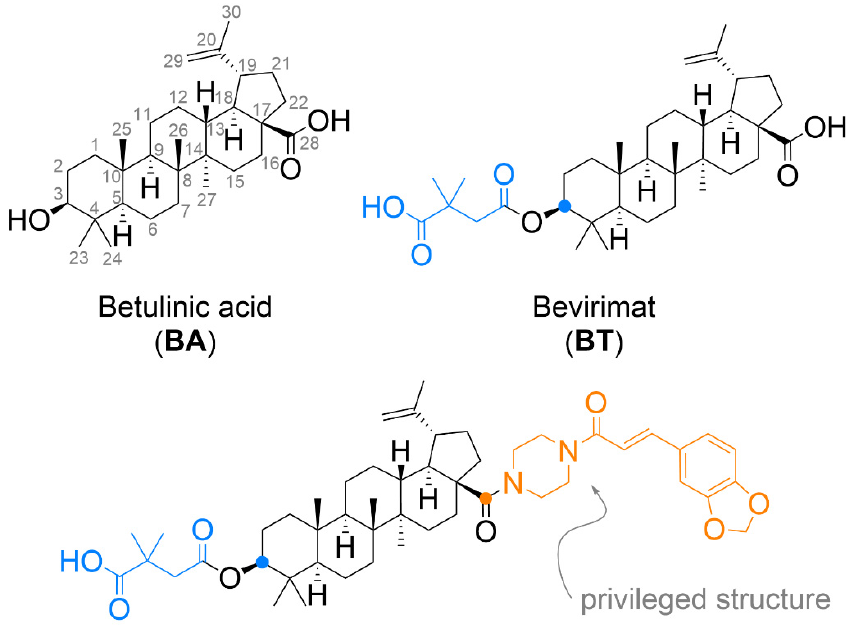
Figure 1. Chemical structure of betulinic acid and its derivatives.